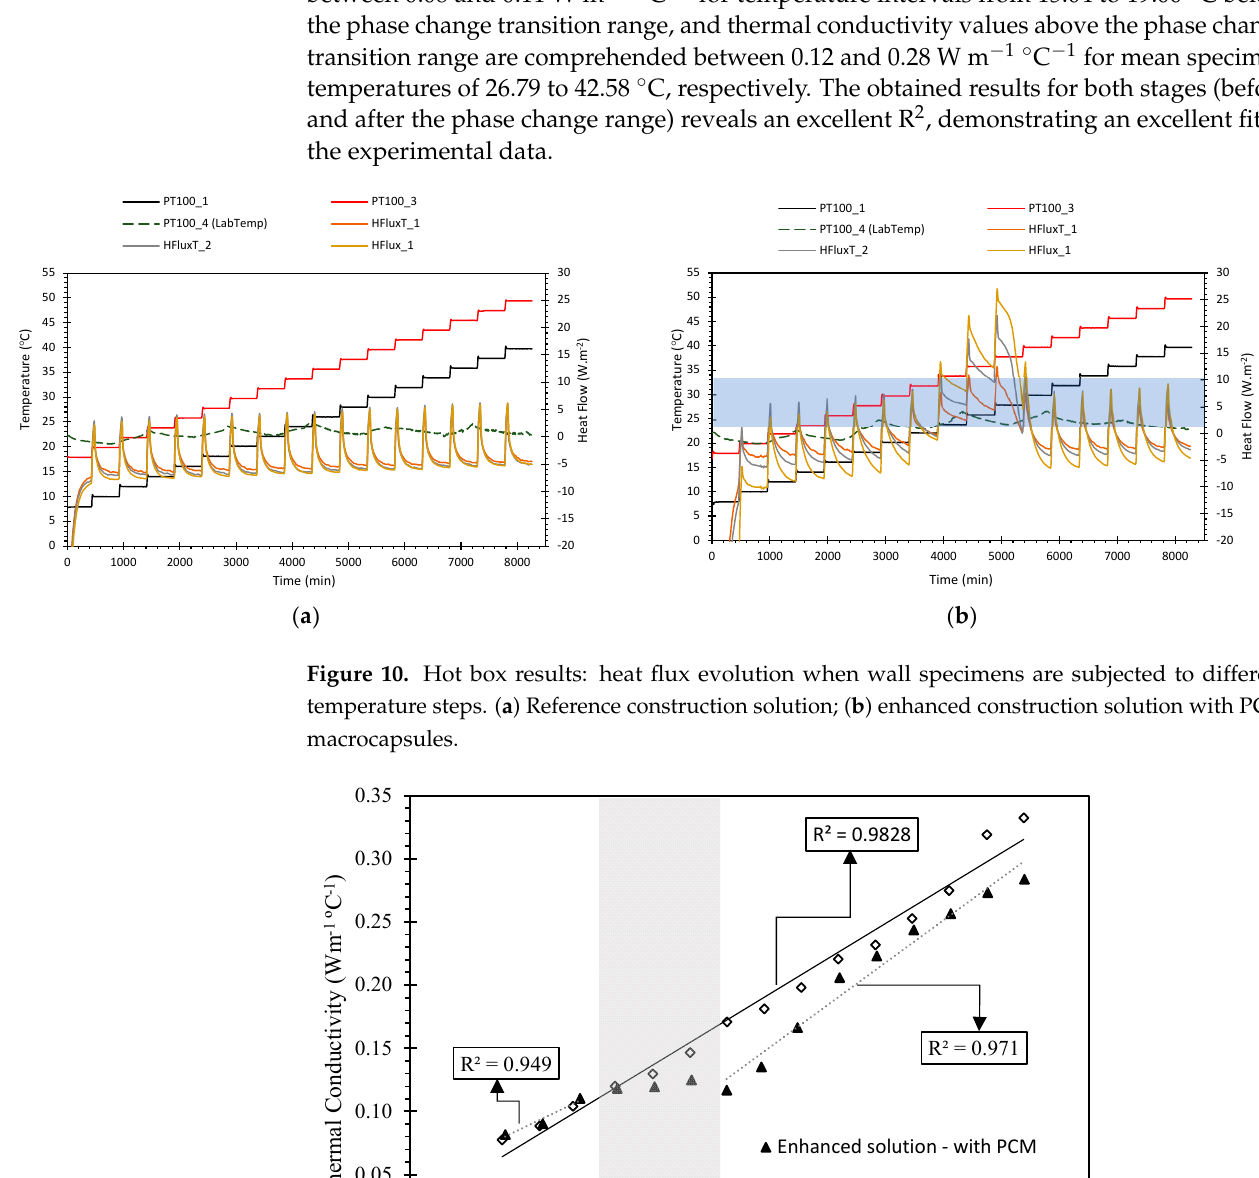
Figure 11. Equivalent thermal conductivity as function of the mean specimen temperature for both construction solutions.